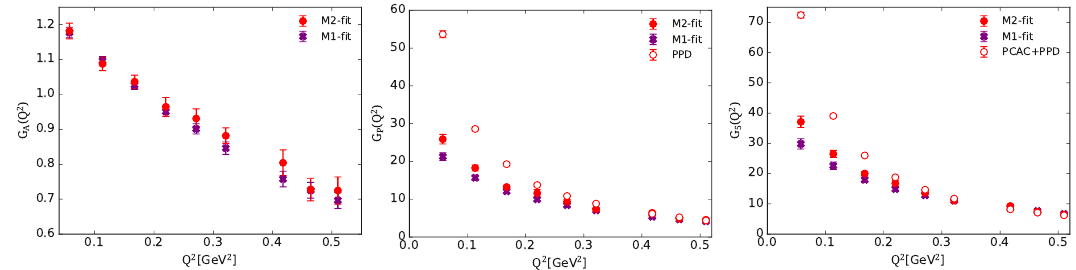
( Q 2 ) (left), G ( Q 2 ) (middle) and G ( Q 2 ) (right) form A P 5 ( Q 2 ) and combining Eq.(8) and Eq. (3) for G ( Q 2 ) P 5